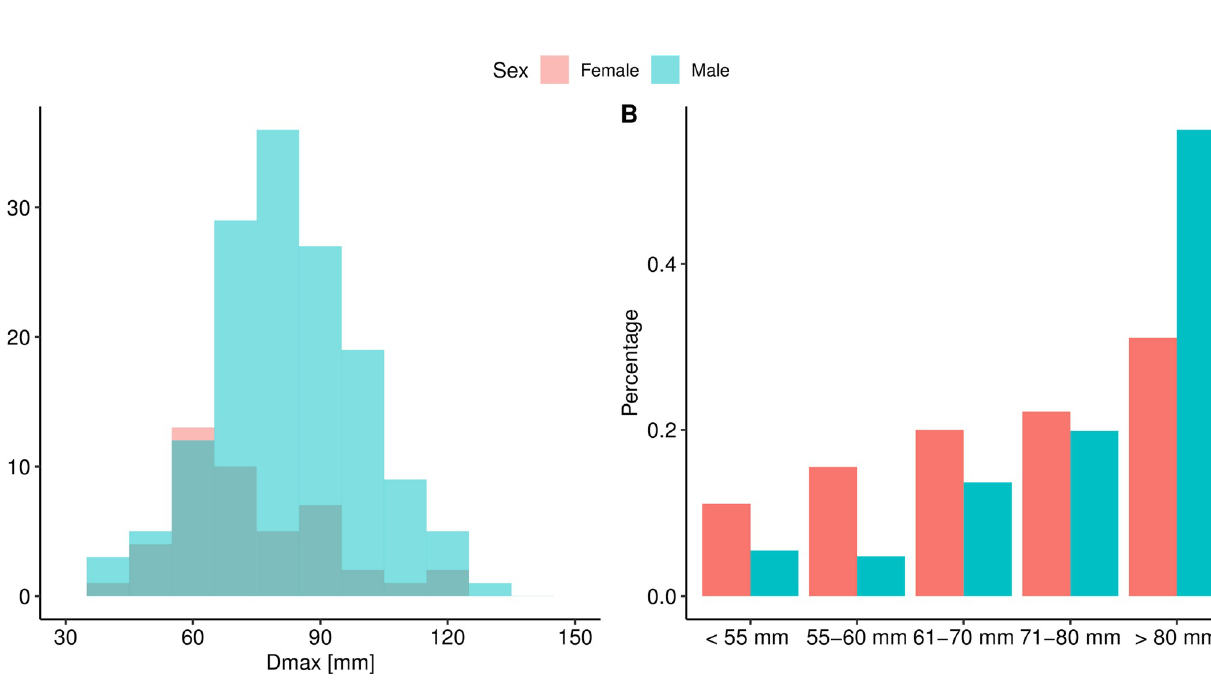
PLOS ONE | https://doi.org/10.1371/journal.pone.0216558 May 28,